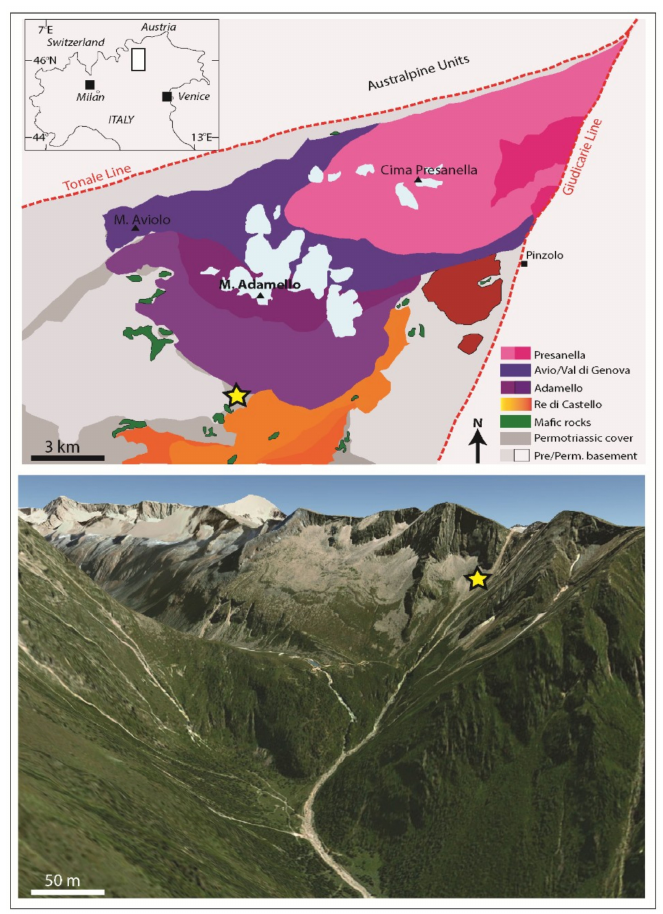
Figure 3. Geological sketch map of the Adamello pluton and a view of the area of Forcel Rosso. Photo by F. Pezzotta. The stars indicate the location of the studied pegmatite